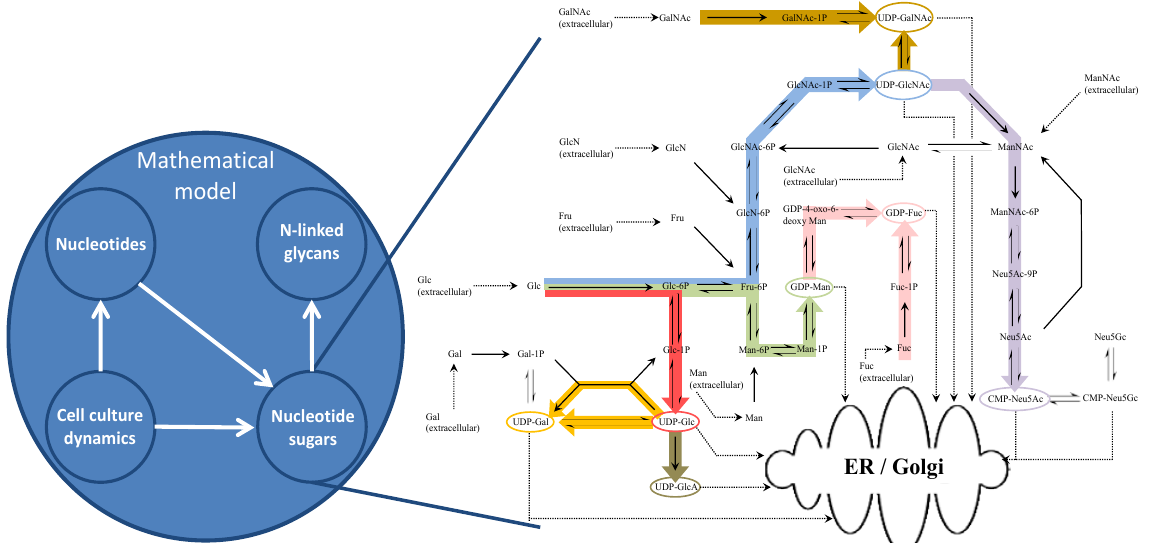
Figure 1. Structure of the mathematical model and the interactions of the individual model parts with a focus on the network for nucleotide sugar